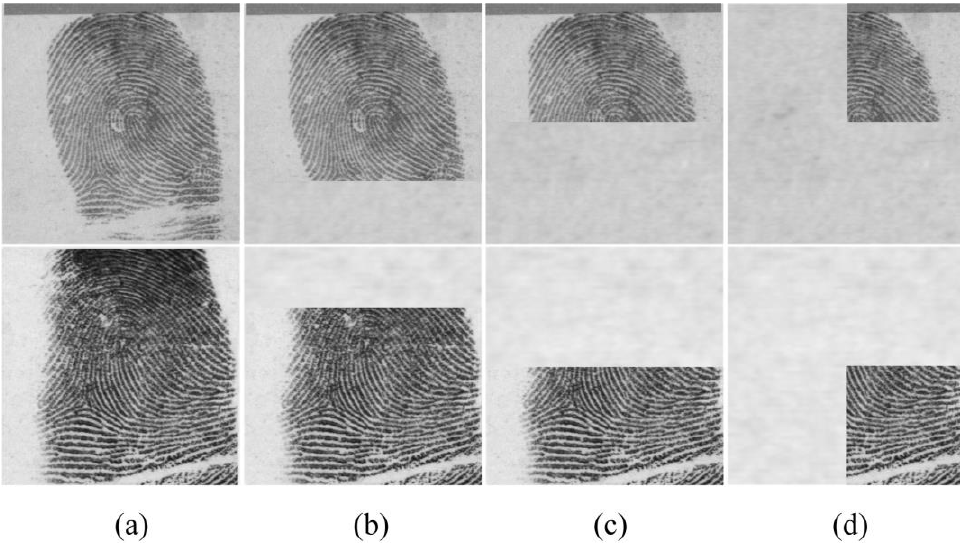
Figure 4. Example images in verification sets. ( a ) is the original fingerprint image, ( b ) is the fingerprint image with 75% effective area, ( c ) is the fingerprint image with 50% effective area, and ( d ) is the fingerprint image with 25% effective area.